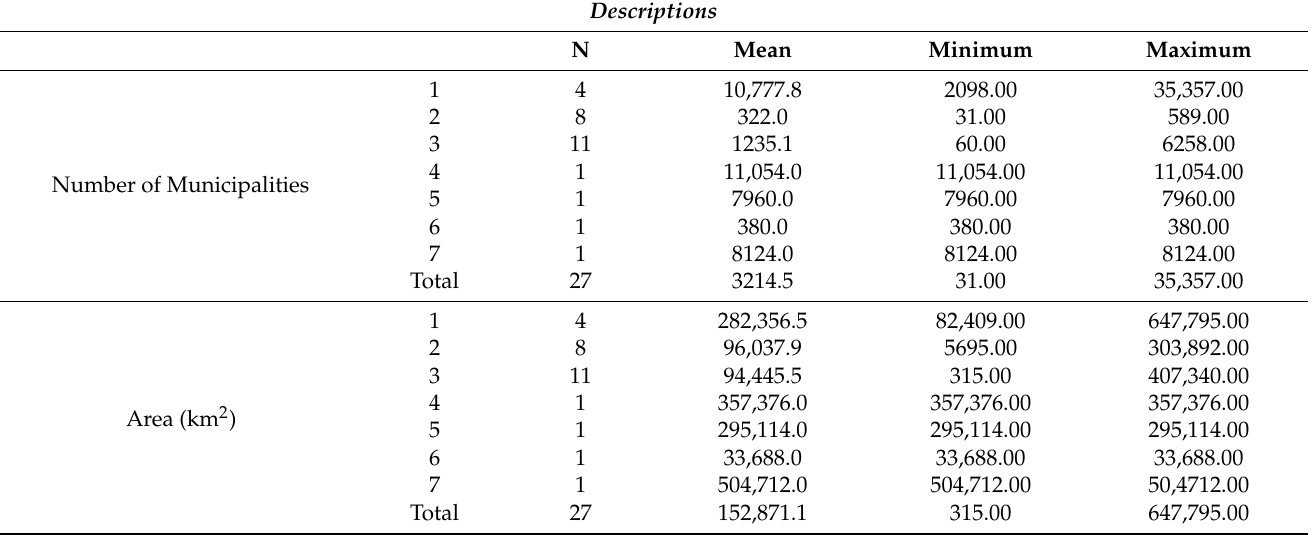
Table A5. Socio-economic characteristics of